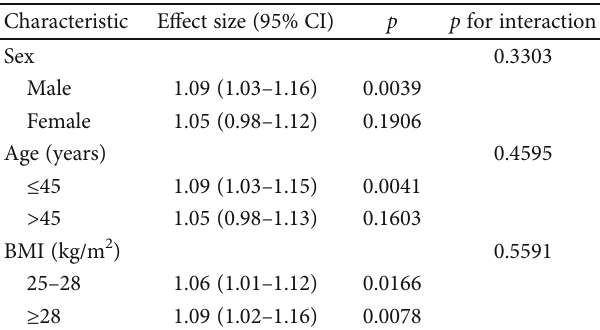
Table 4: E ff ect size of NPY on MUO in